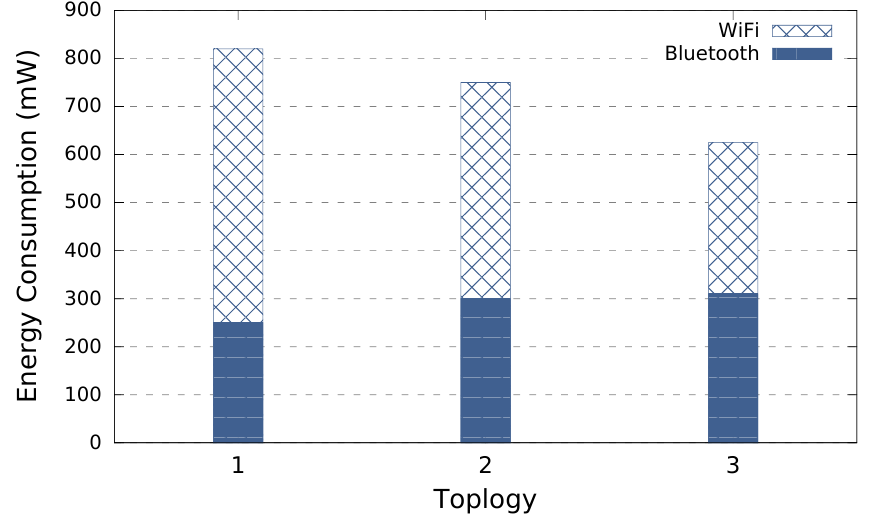
Figure 2. Energy